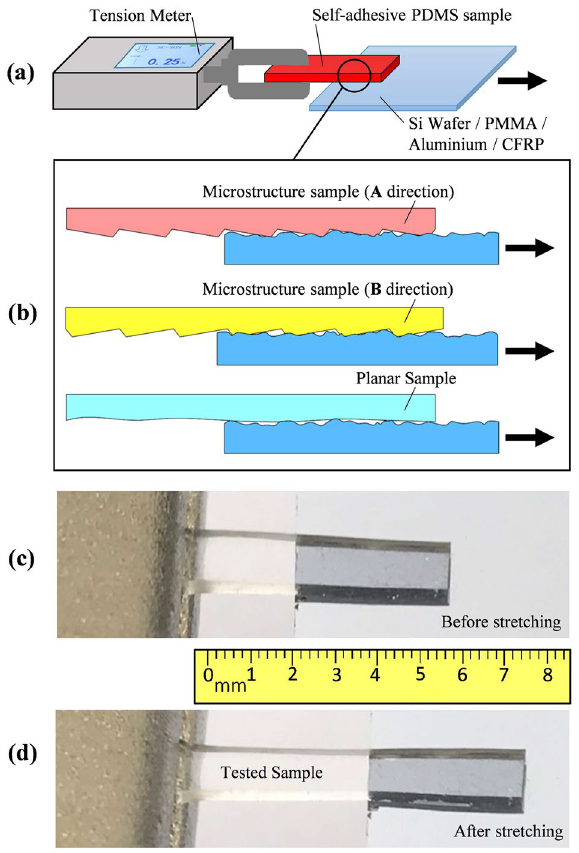
Figure 5. Experimental evaluation of the tangential adhesion force provided by the manufactured self-adhesive PDMS packaging. ( a ) Experimental setup. ( b ) Definition of pulling directions depending on the microstructure orientation. ( c ) Photo of self-adhesive sample before tangential force is applied. ( d ) Photo of self-adhesive sample after tangential force is